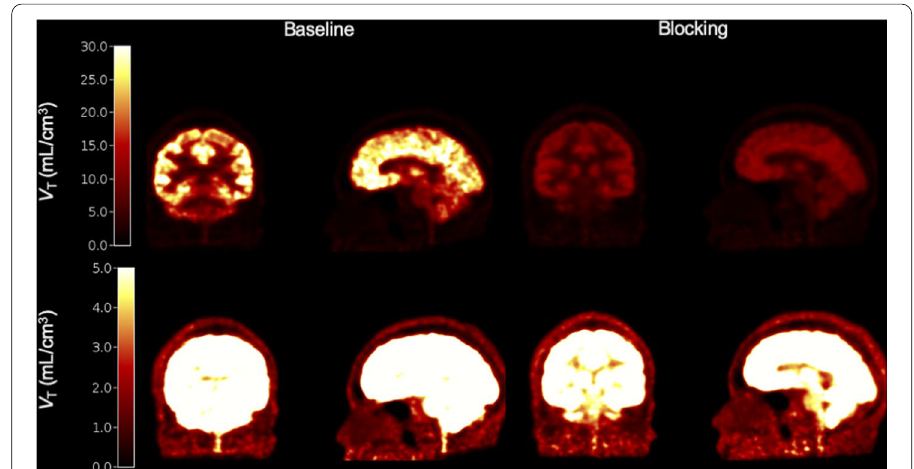
Fig. 2 Example baseline (left) and blocking (right) [ 11 C]UCB-J V T coronal and sagittal images in the whole brain and cSC from the HRRT study. Images are scaled to brain uptake levels in the top row and scaled to cSC uptake in the bottom row